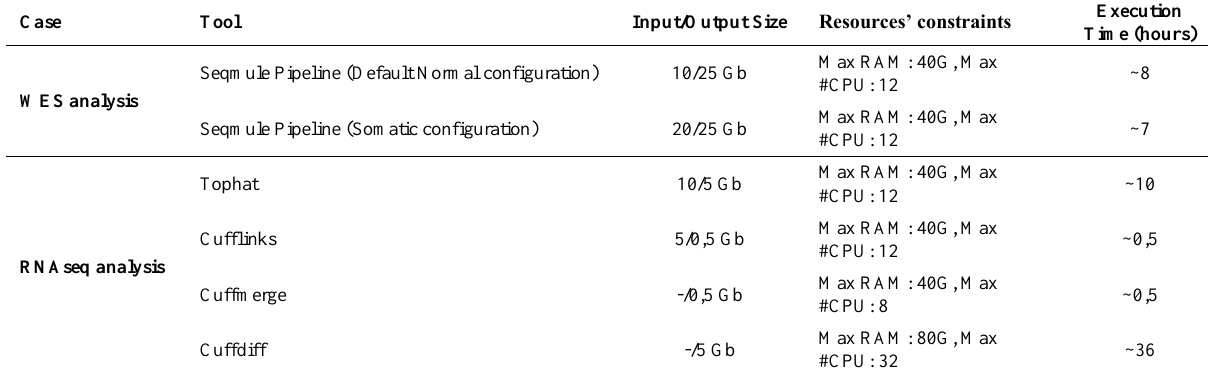
Table 2. Performance and resources for the external